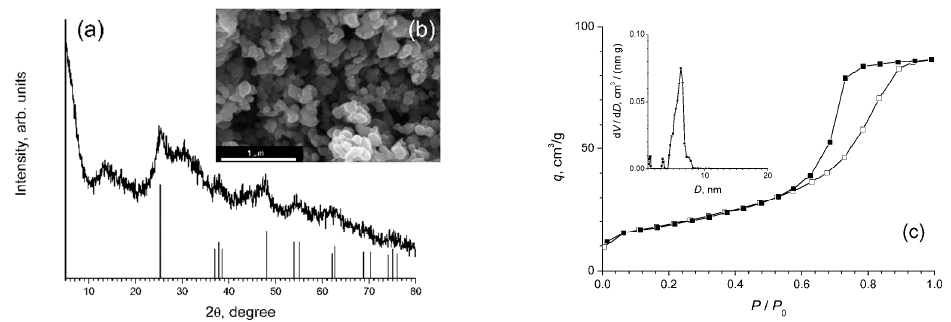
Figure 1. The analysis results of titanium dioxide powder obtained by hydrolysis of titanium isopropoxide in ethanol, using ( a ) XRD (Bragg positions correspond to anatase); ( b ) SEM; ( c ) low-temperature nitrogen adsorption. The inset shows the pore size distribution.